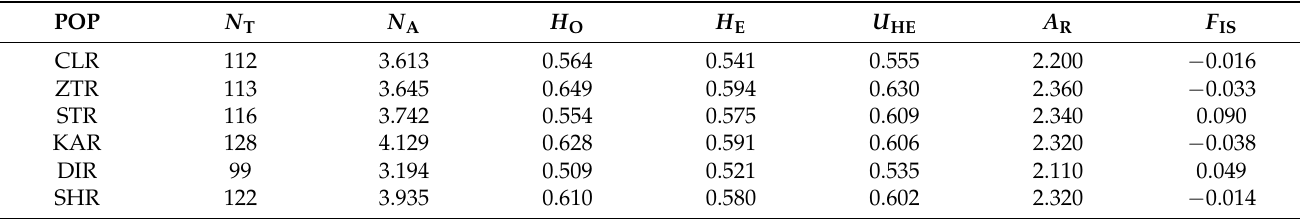
Table 2. Statistical diversity parameters of walnut from Pakistan derived from 31